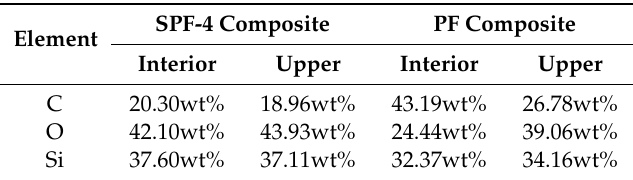
Figure 17. The SEM images for SPF ‐ 4 composites ( a ) and PF composites ( b ) before ablation; the SEM images for the surface of SPF ‐ 4 composites ( c ) and PF composites ( d ) after ablation; the SEM images for the fractured surface of SPF ‐ 4 composites ( e ) and PF composites ( f ) after ablation. Table 2. The corresponding EDX results for the interior and the upper of SPF ‐ 4 composites and PF composites after ablation.